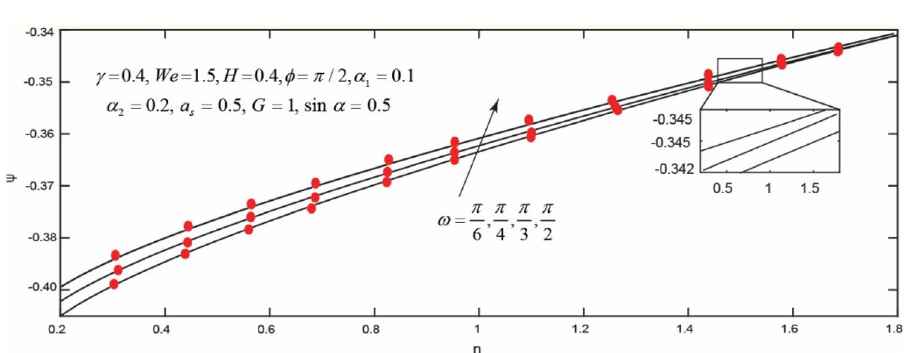
Figure 4. Impact of inclined angle ω on powered transferred by